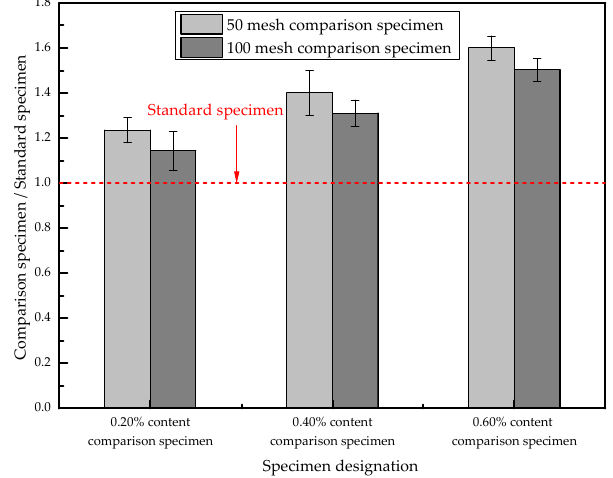
Figure 11. Comparison of the tortuosity of each sample group.